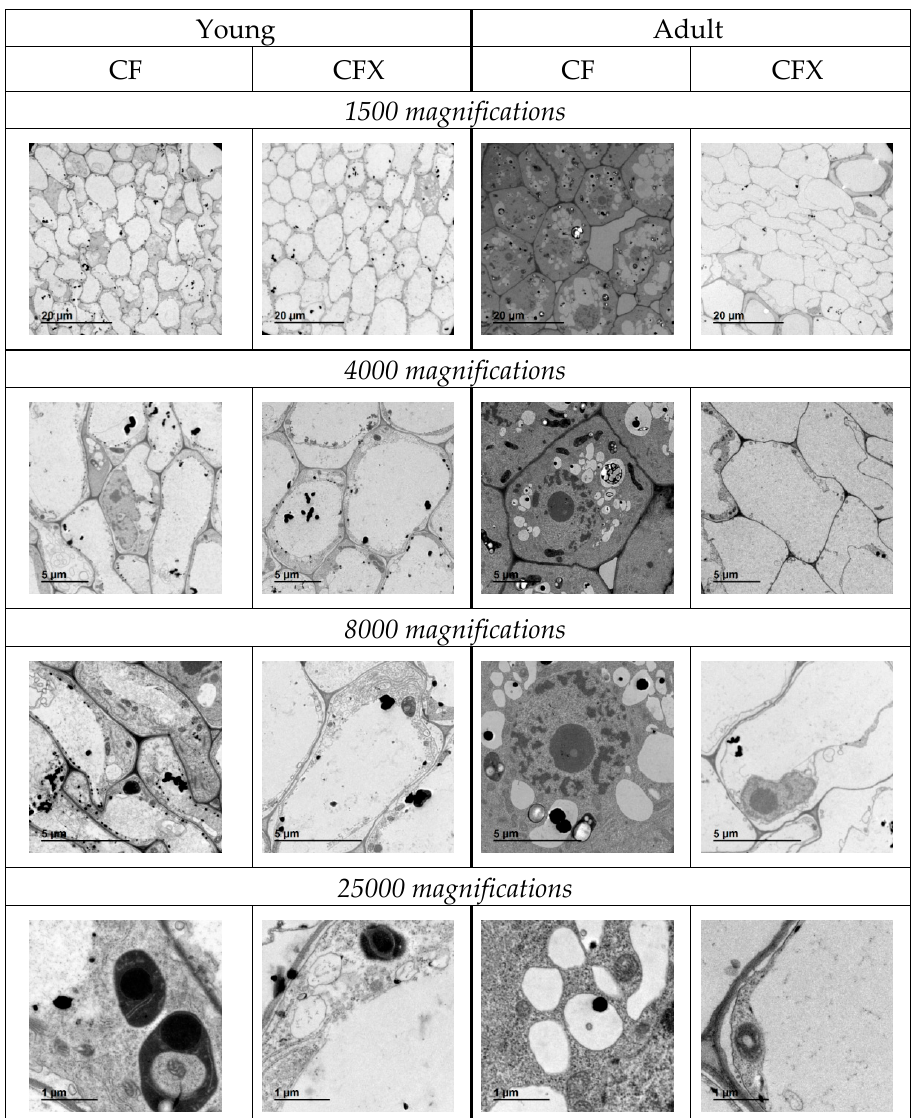
Figure 5. Transverse photographs of the roots of pepper plants fertigated with conventional fertilization (CF) and conventional fertilization plus TX (CFX) grown in hydroponics at 1500, 4000, 8000 and 25,000 magnifications obtained by transmission electron microscopy (TEM).